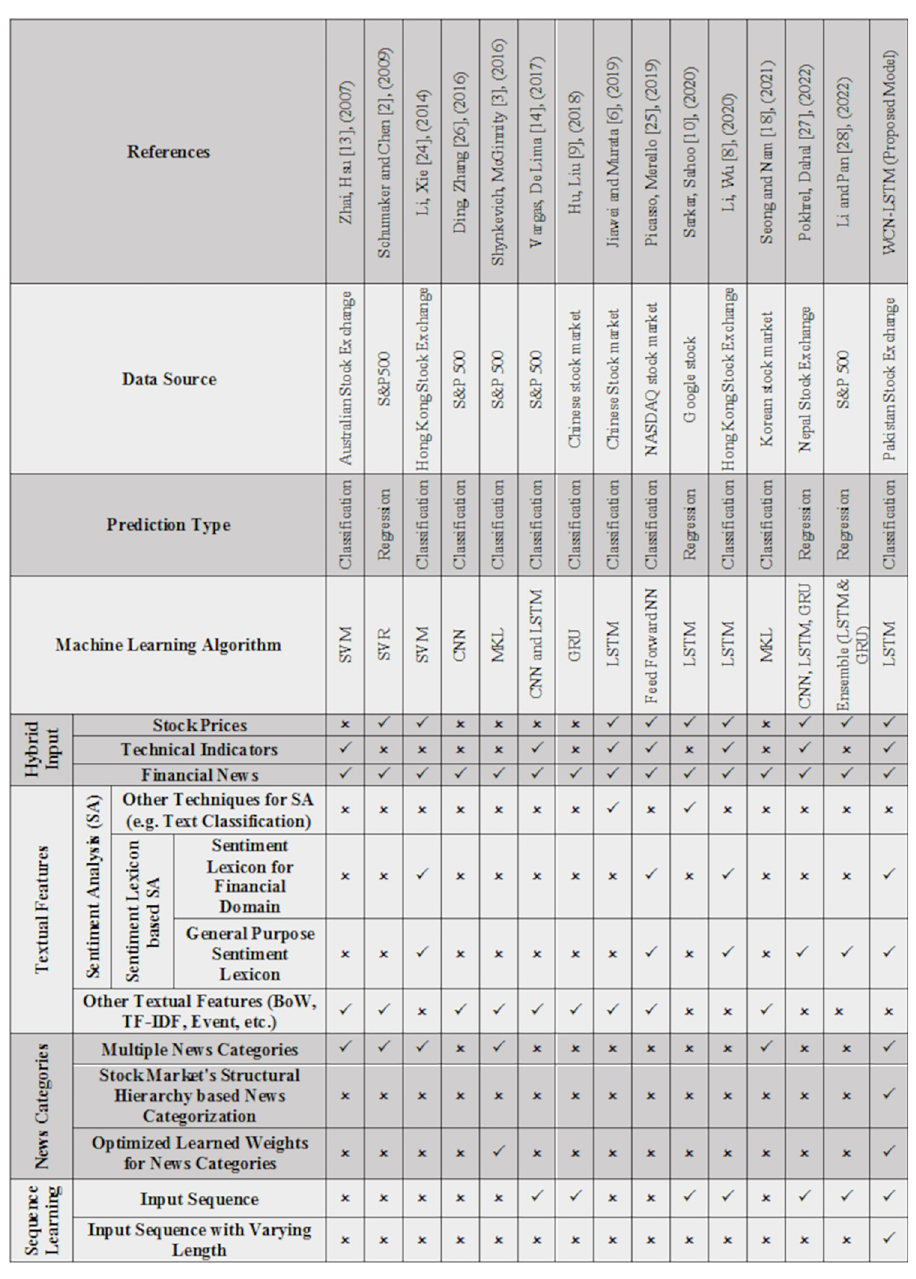
Fig 13. Comparison between WCN-LSTM and existing stock prediction model’s